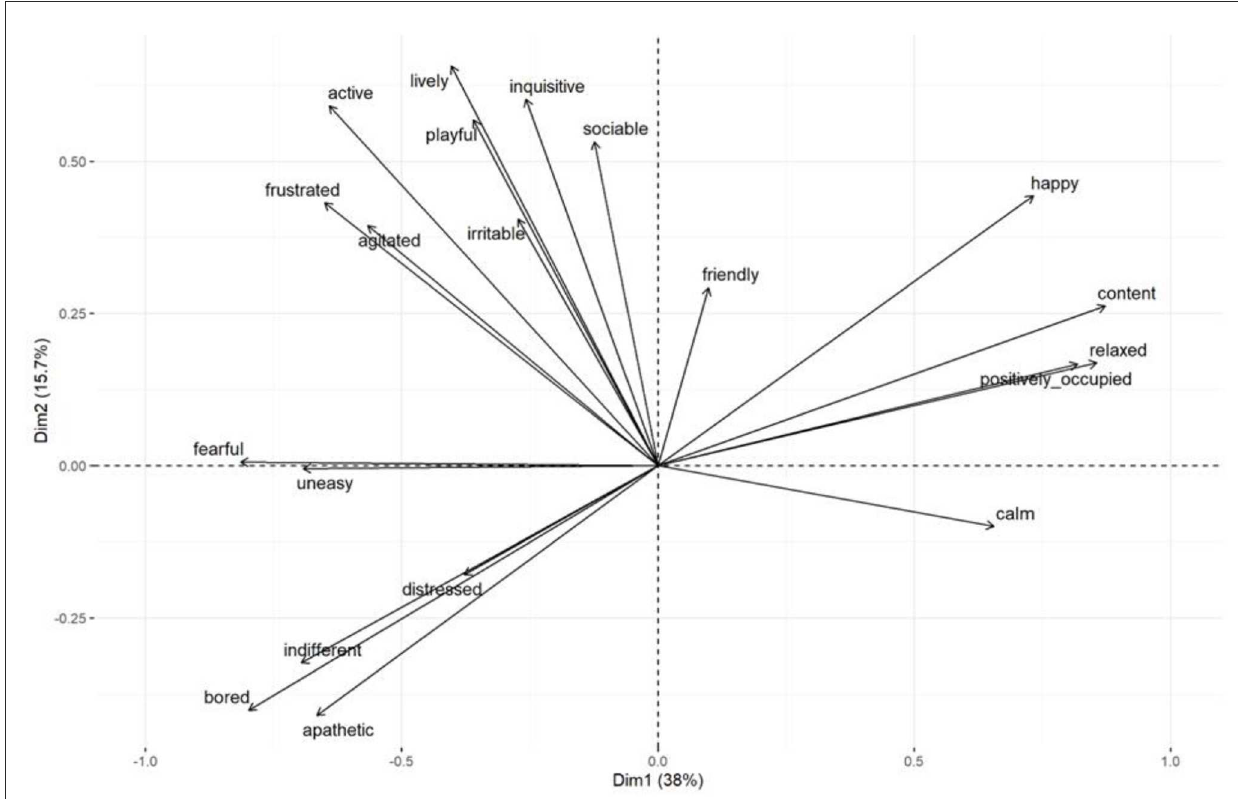
FIGURE8 Group 1 and 2 combined: Variable correlation plot displaying the relationship between all variables in PC1 (Dim1) and PC2 (Dim2) and each terms value figure in contribution to the principal component.